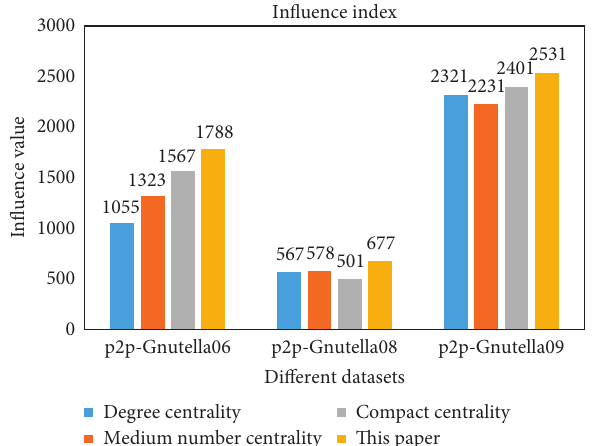
Figure 7: Influence index comparison of different methods.